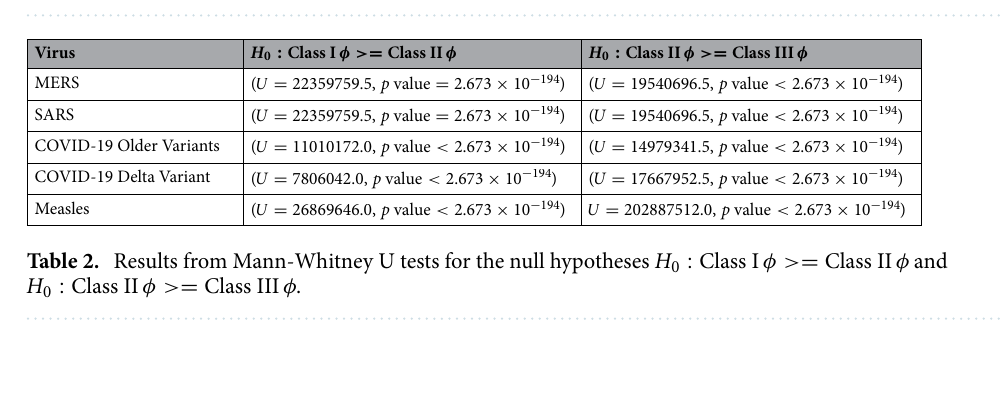
Figure 10. Effectiveness of Class I, II, and III strategies on outbreak size measured as final infected ratio, φ , for different contagious respiratory viruses compared by secondary attack rate.